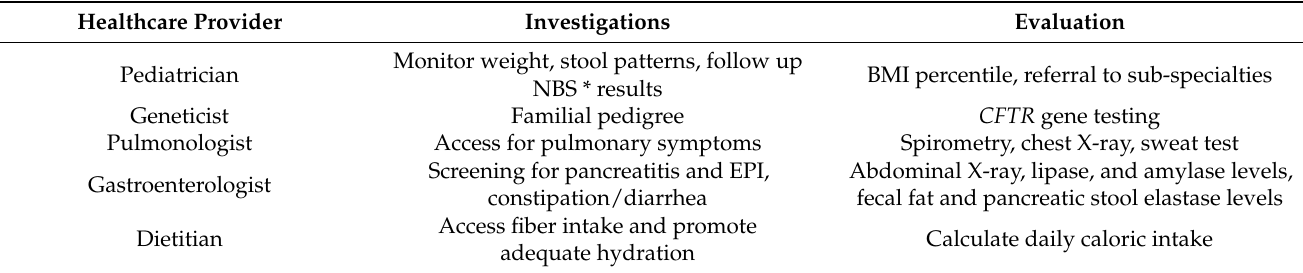
Table 4. Pediatric multidisciplinary approach and clinical investigations for CF, CRD, and CRMS in Puerto Rico.